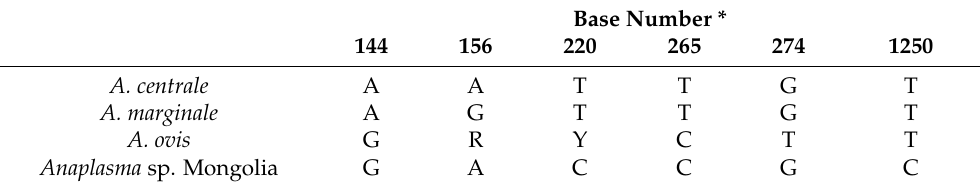
Table 4. Differentiating bases for the ruminant clade of Anaplasma species.